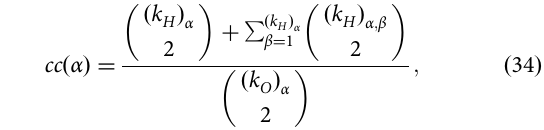
The observed network can be recovered from the hidden network by converting every wedge in G H into a triangle. This can be thought of as complete triadic closure where every possible triangle which can be closed, from the addition of a single edge to the hidden network, is closed. This implies that the CCM has the largest possible transitivity from a single iteration of triadic closure on a random recursive tree. The local clustering coef fi cient, cc( α ), is de fi ned as the number Þ α , normalised by the the of edges between the ð k α neighbours of O Þ number of edges in a complete subgraph of size ð k α . For the O